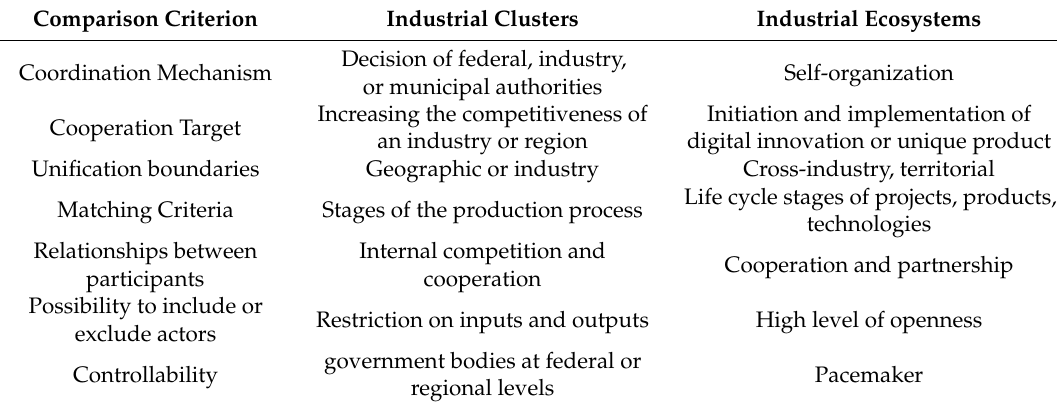
Table 1. Comparative analysis of cluster and ecosystem